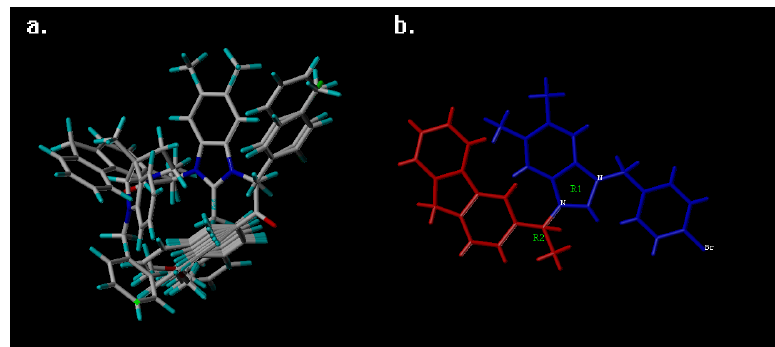
Figure 1. The result of the database alignment using CoMSIA technique ( a ) and topomer fragment method using the topomer CoMFA technique ( b ), the fragment 1 was painted in blue and the fragment 2 was painted in red.